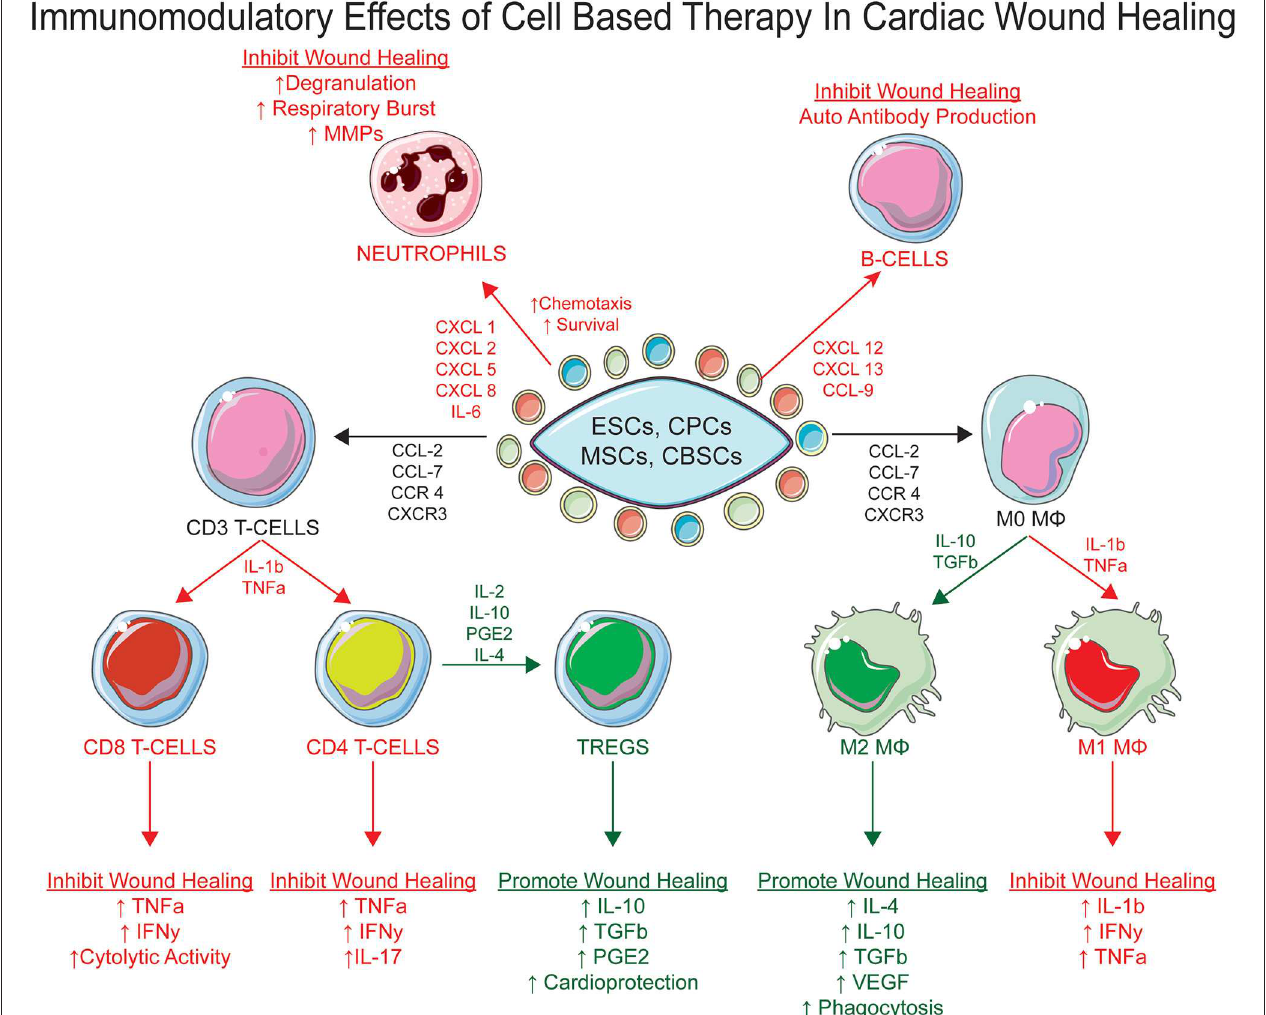
FIGURE 1 | The immunomodulatory effects of stem cell therapy post myocardial infarction. The paracrine secretome produced by cell based therapy can directly mediate the inflammatory microenvironment of the infarcted heart by acting on multiple immune cell subsets to promote myocardial wound healing, specifically neutrophils, M 8 s, T-Cells, and